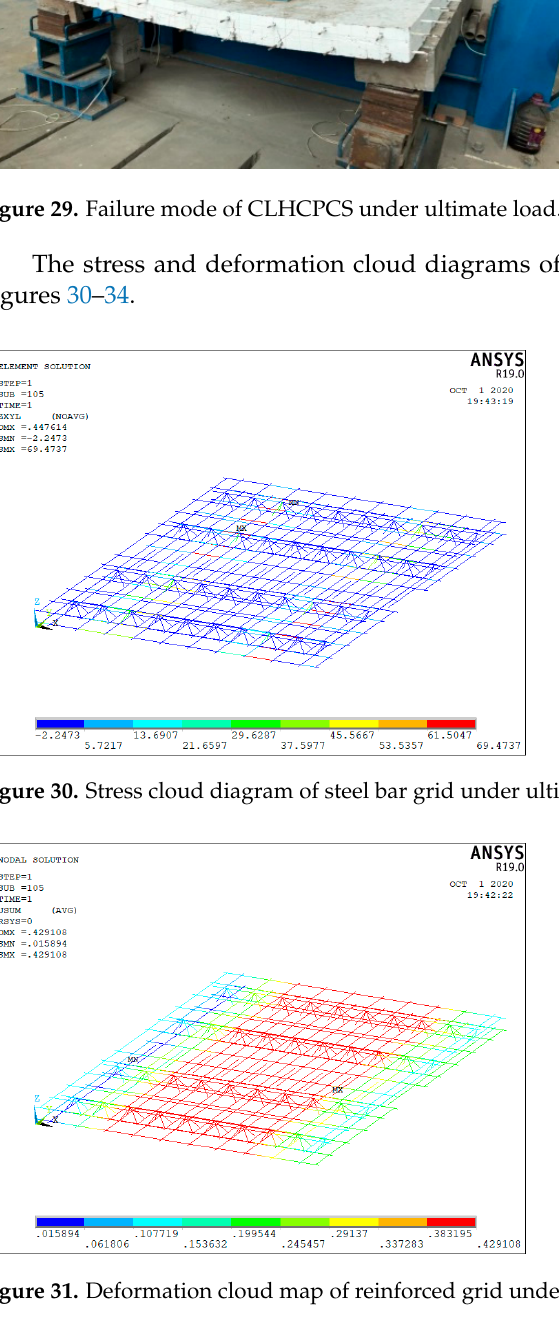
Figure 31. Deformation cloud map of reinforced grid under ultimate load.